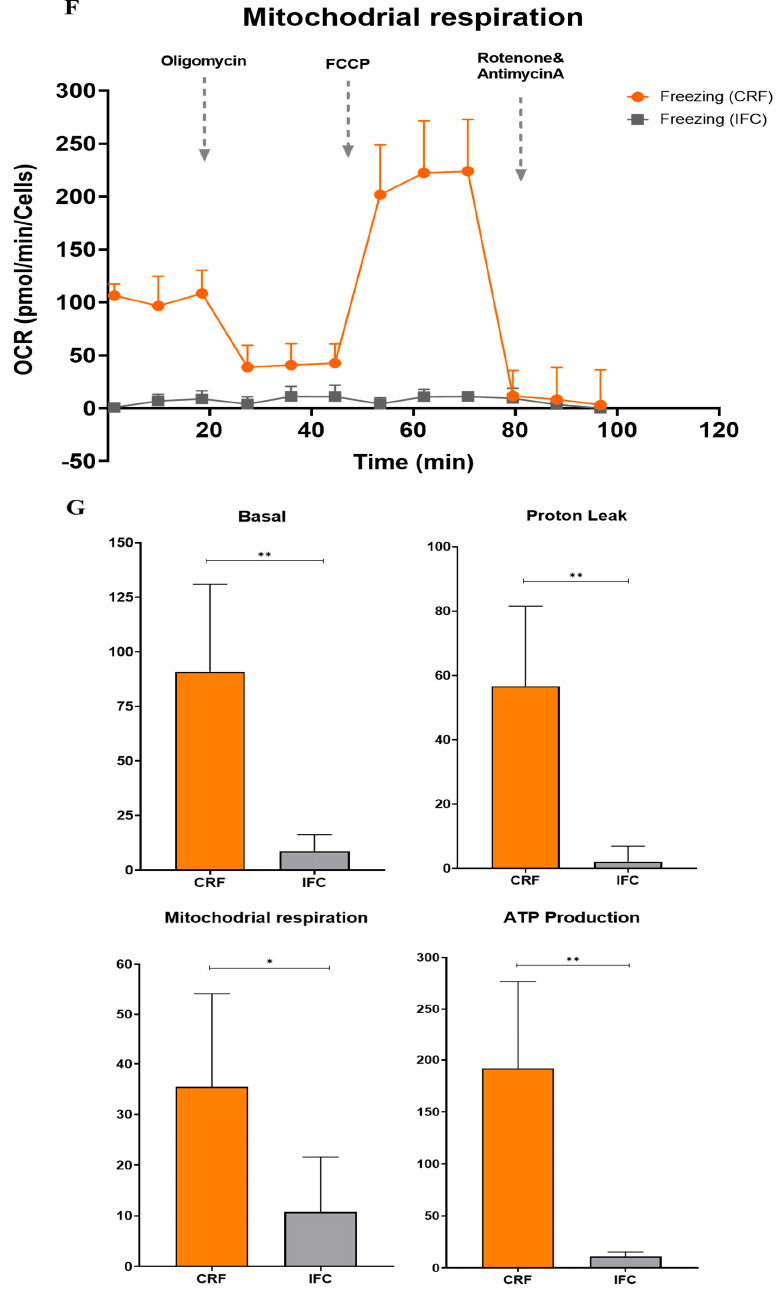
Figure 4. Cryopreservation of pancreatic islet cells isolated from partial pancreatic tissue. ( A ) Morphology and viability of islet cells cultured without cryopreservation and after freez- ing/thawing using ( A_1 ) Dithizone staining of islet cells cultured without freezing/thawing ( A_2 ) FDA/PI staining of islet cells cultured without freezing/thawing ( B ) an isopropanol-based